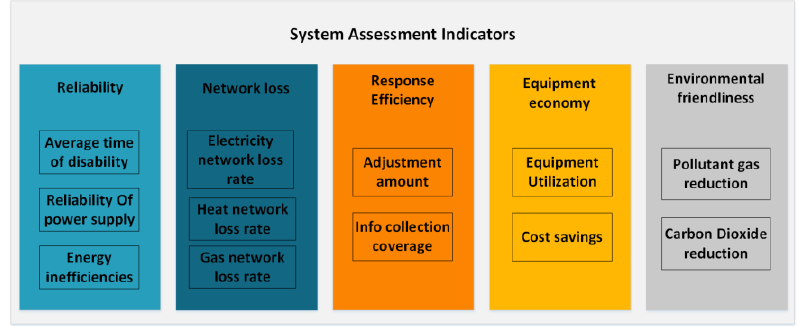
Figure 6. Classification of system evaluation indicators.